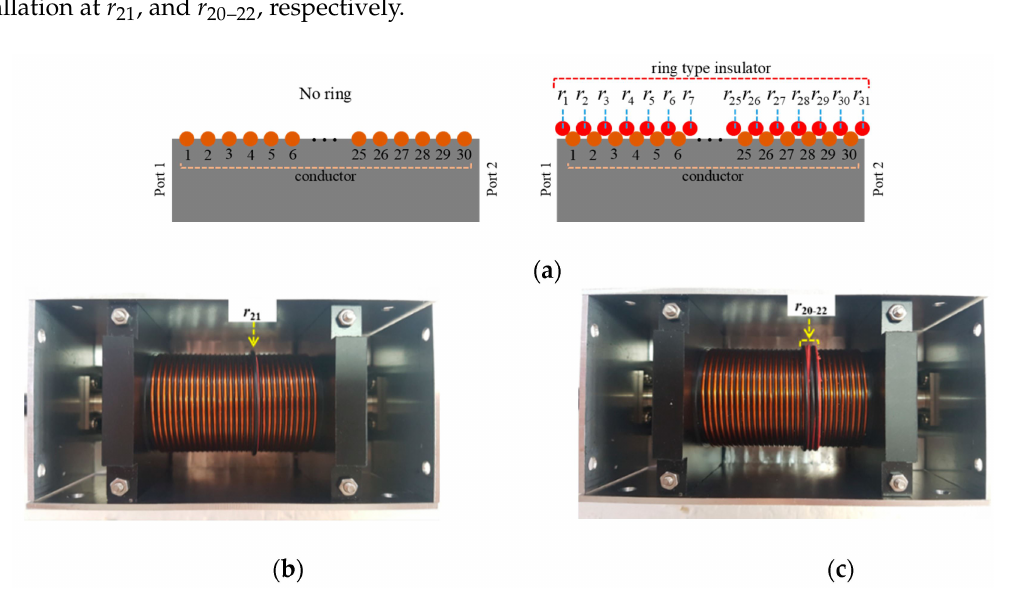
Figure 6. Installation of ring-type insulators on the solenoid. ( a ) 30 conductor turns and 31-ring insulatorsarenumberedfromleftandtoright. ( b )Apictureofthesolenoidwhenthe21stringisinstalled, ( c ) A picture of the solenoid when three rings from the 20th to 22nd ring are installed,